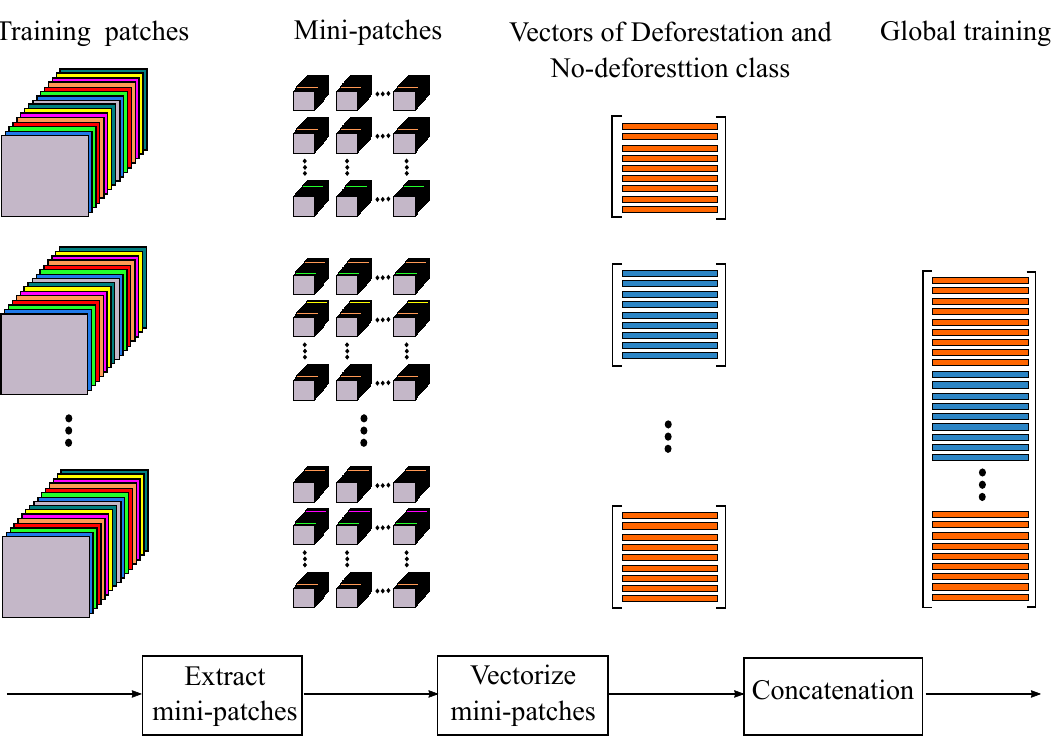
Figure 3. Procedure to train the SVMs filter bank. Mini-patches are extracted from input patches, and they are vectorized to compose the training set of